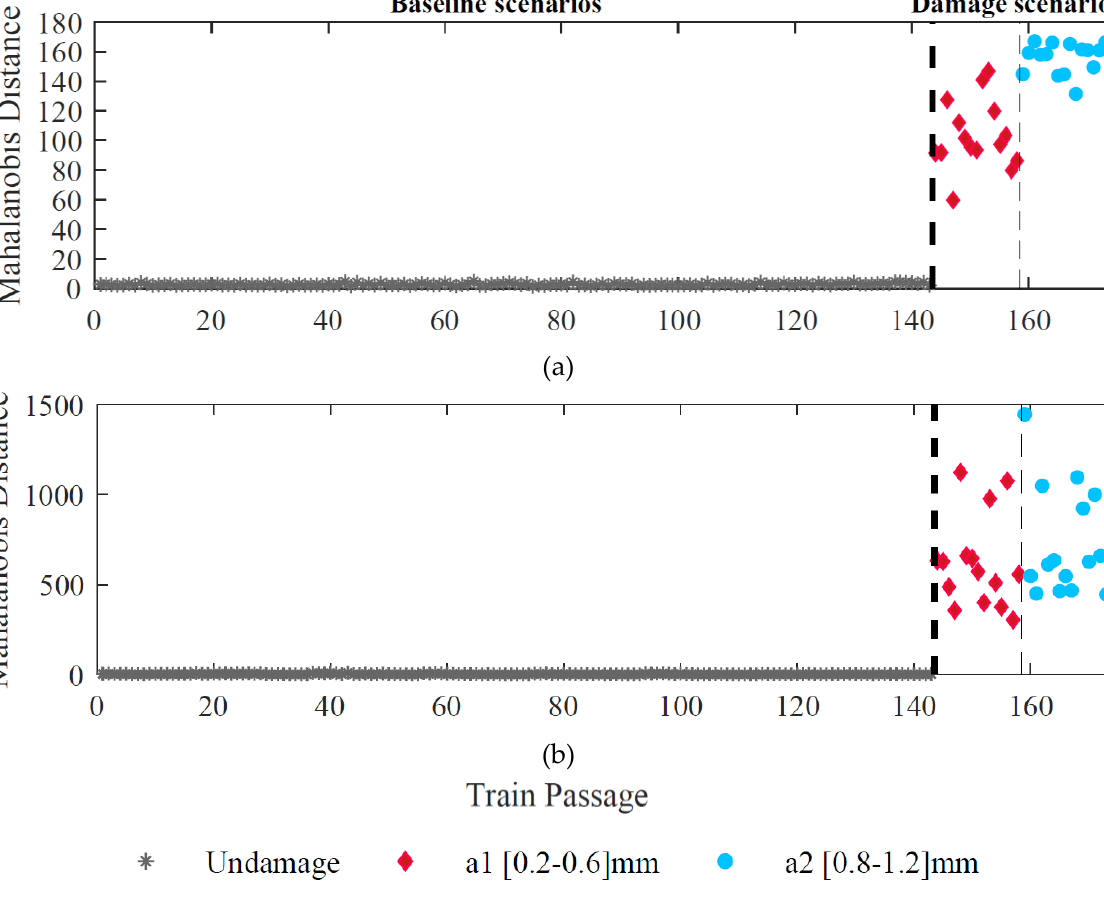
Figure 16. Sensors fusion, ( a ) ARX – PCA – based, ( b ) CWT – double – PCA – based.